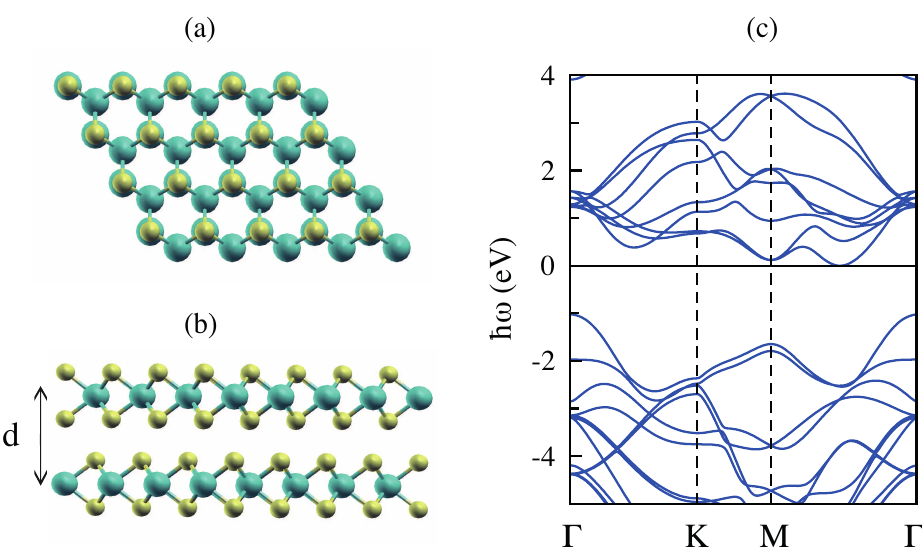
Figure 11. ( a , b ) Top and side view of bilayer molybdenum disulfide (BL.MoS 2 ). ( c ) The band structure of BL.MoS 2 along the high symmetry Γ − K − M − Γ directions. The Fermi level is set at 0 eV, and interlayer separation d is 5.89 Å.